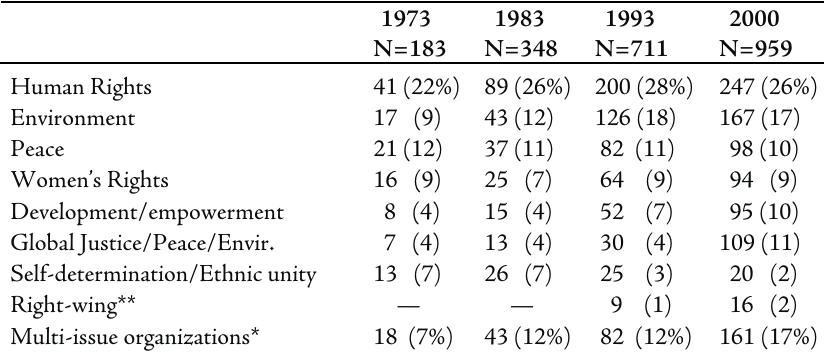
Table 2: Issue Focus of Transnational Social Movement Organizations Number of Organizations